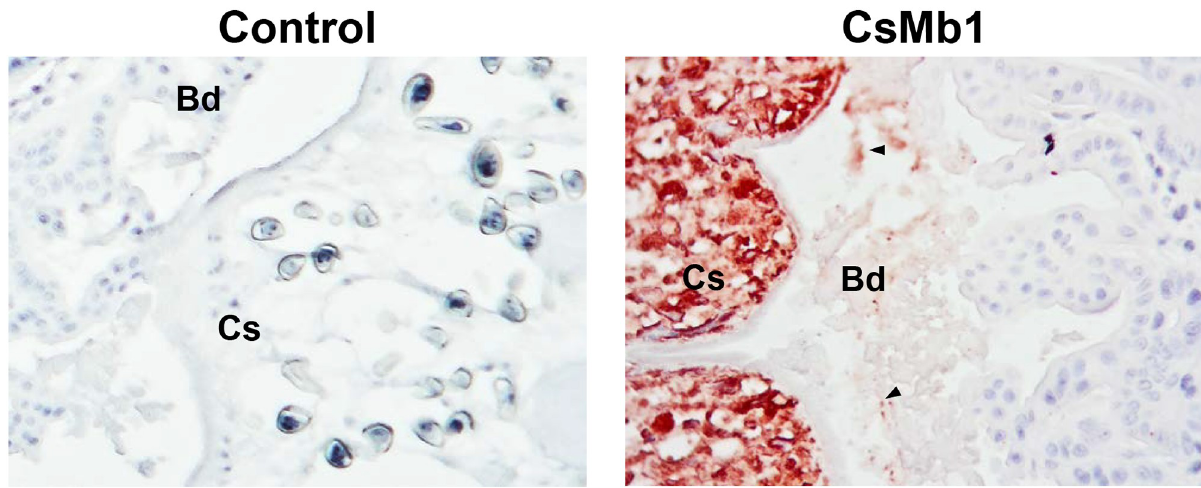
Fig 9. Detection of secreted CsMb1 in the epithelium of rat bile ducts with clonorchiasis. Histologic sections containing the intrahepatic bile ducts, which were prepared from the liver of an experimental rat with clonorchiasis, sequentially reacted with an anti-CsMb1 antibody or pooled mouse serum (n = 3) and a goat anti-mouse IgG antibody conjugated with horseradish peroxidase (HRP). The positive reactions were visualized by staining with a red chromogen substrate for HRP. The arrowheads indicate examples of the strong positive signal. Bd, epithelium of the bile duct; Cs, Clonorchis sinensis worm body. Original magnifications, x